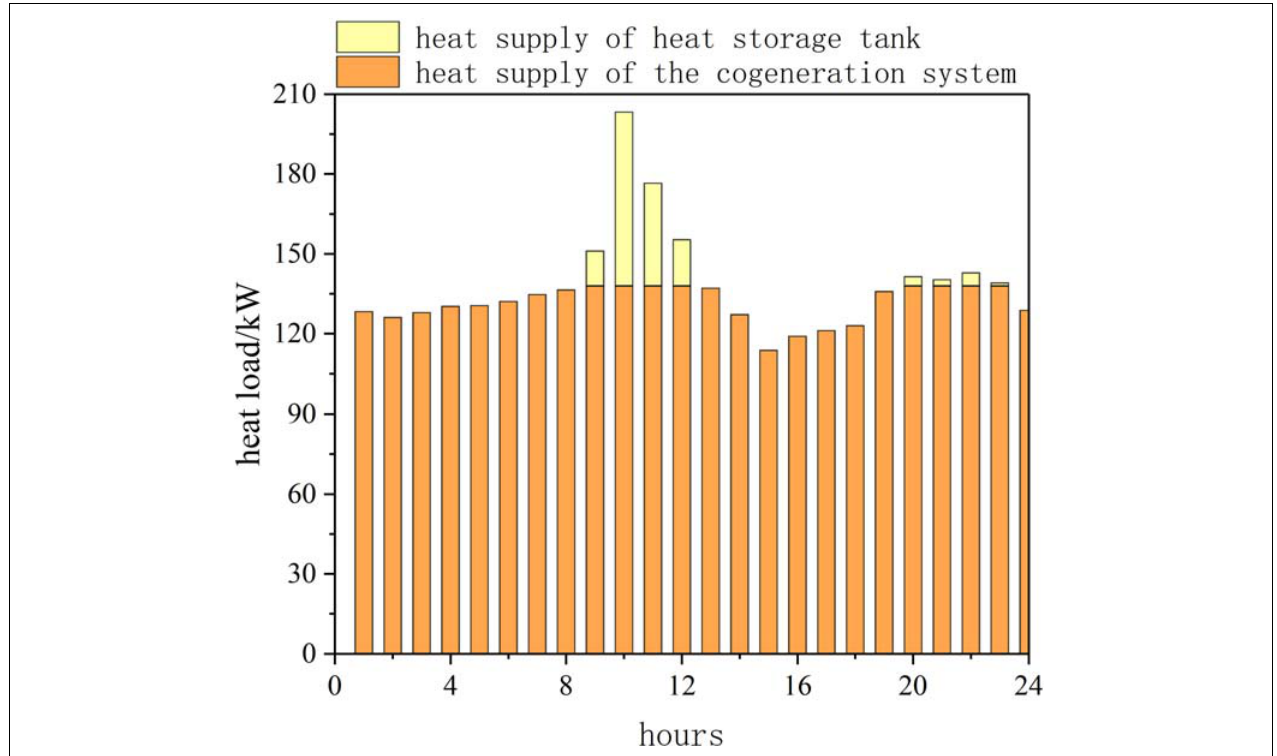
FIGURE 6 | Thermal energy supply on a typical winter